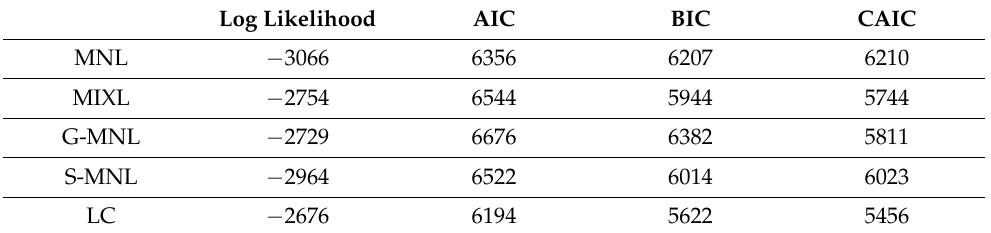
Table 2. Results of the model selection criteria (AIC, BIC, CAIC) for alternative models. Log Likelihood AIC BIC CAIC MNL − 3066 6356 6207